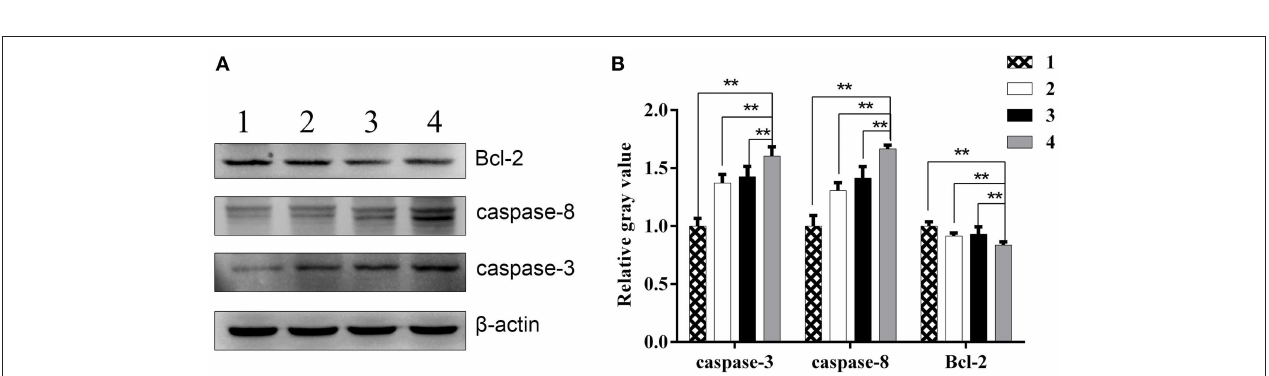
FIGURE 6 | The expression of apoptosis related proteins in xenografts. (A) Western blot analysis of Bcl-2, caspase-3, and caspase-8 protein levels in xenografts of different groups. (B) Quantitative analysis of relative Bcl-2, caspase-3, and caspase-8 protein levels in xenografts of different groups. 1, PBS; 2, radiation; 3, ZD55-IL-24; 4, combination of ZD55-IL-24 and radiation. ** P < 0.01 vs. combination group.